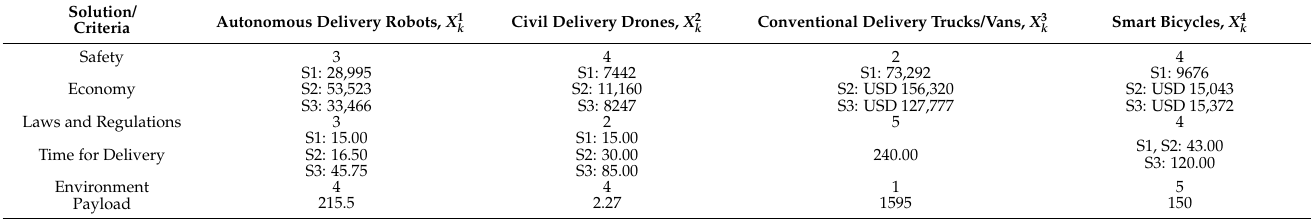
Table 6. Before normalizing scores in the case of all the scenarios (unless otherwise mentioned).